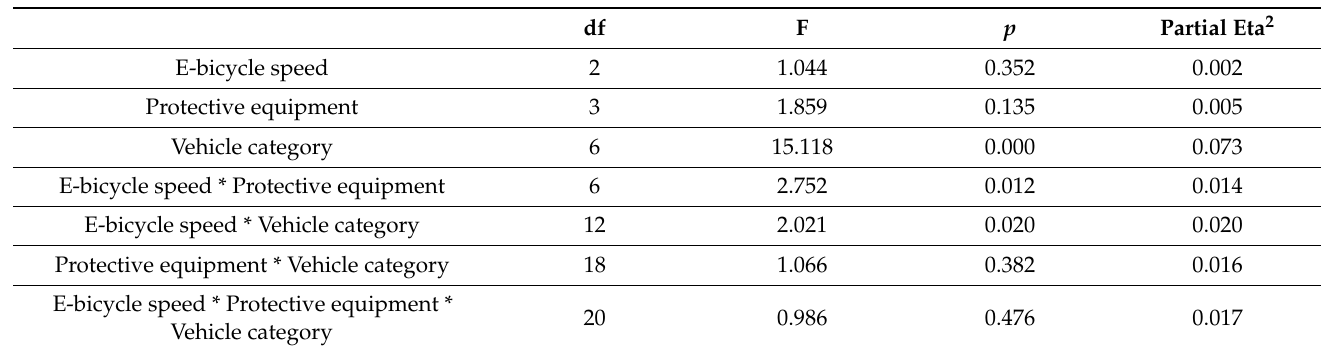
Table 3. Results of the impact of protective equipment, e-bicycle speed, and vehicle category on the lateral distance when overtaking an e-bicycle, based on the three-way ANOVA. df F p Partial Eta